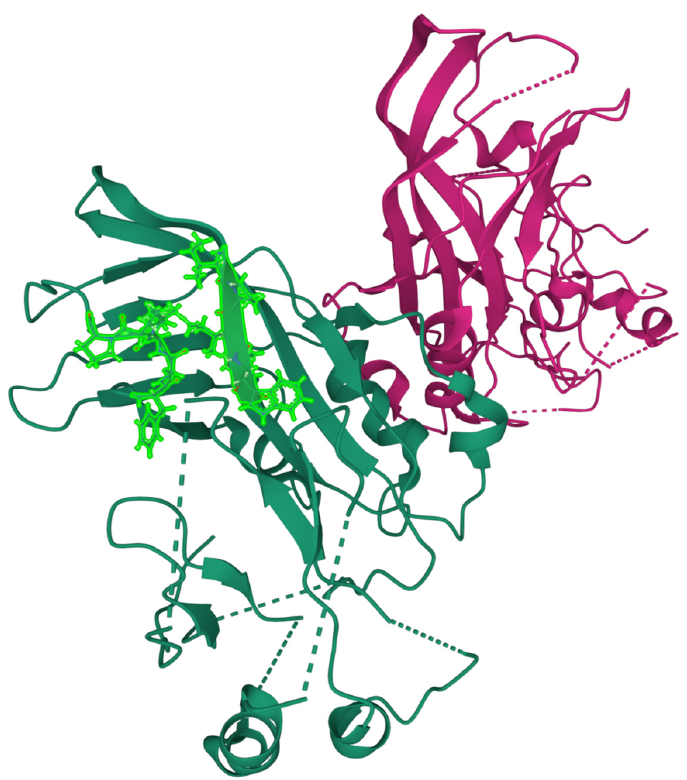
Figure 3. The best predicted primary contact in the native structure of VP40 (PDB structure 7JZT); the side chains of the amino acids included in the contact-defining segments are represented [62]. The structure is a dimer, and the primary contact has been represented only on a single chain for clarity.